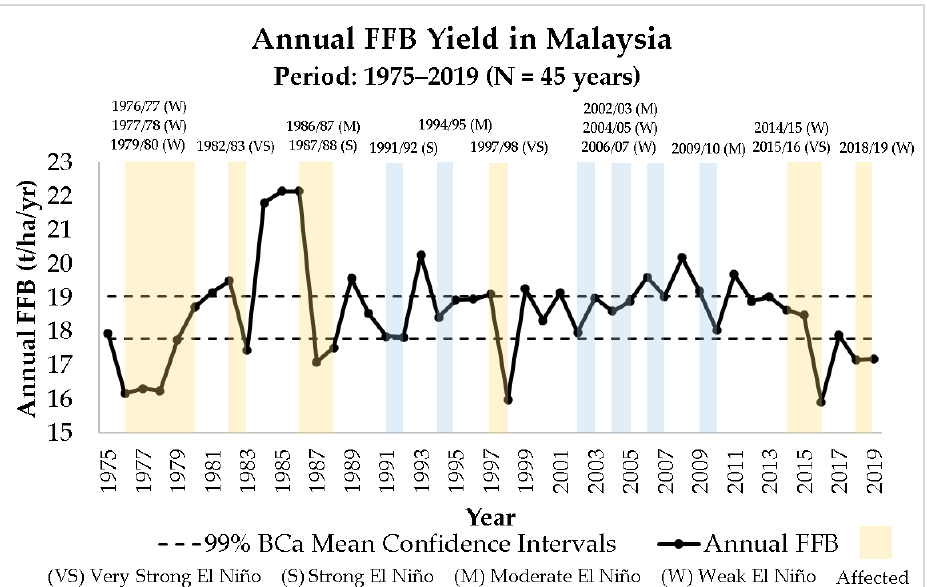
Figure 1. Annual FFB yield in Malaysia from 1975 to 2019 and corresponding El Niño events [7 – 9,24,25]. the Malaysian palm oil industry on the global scale can be enhanced.